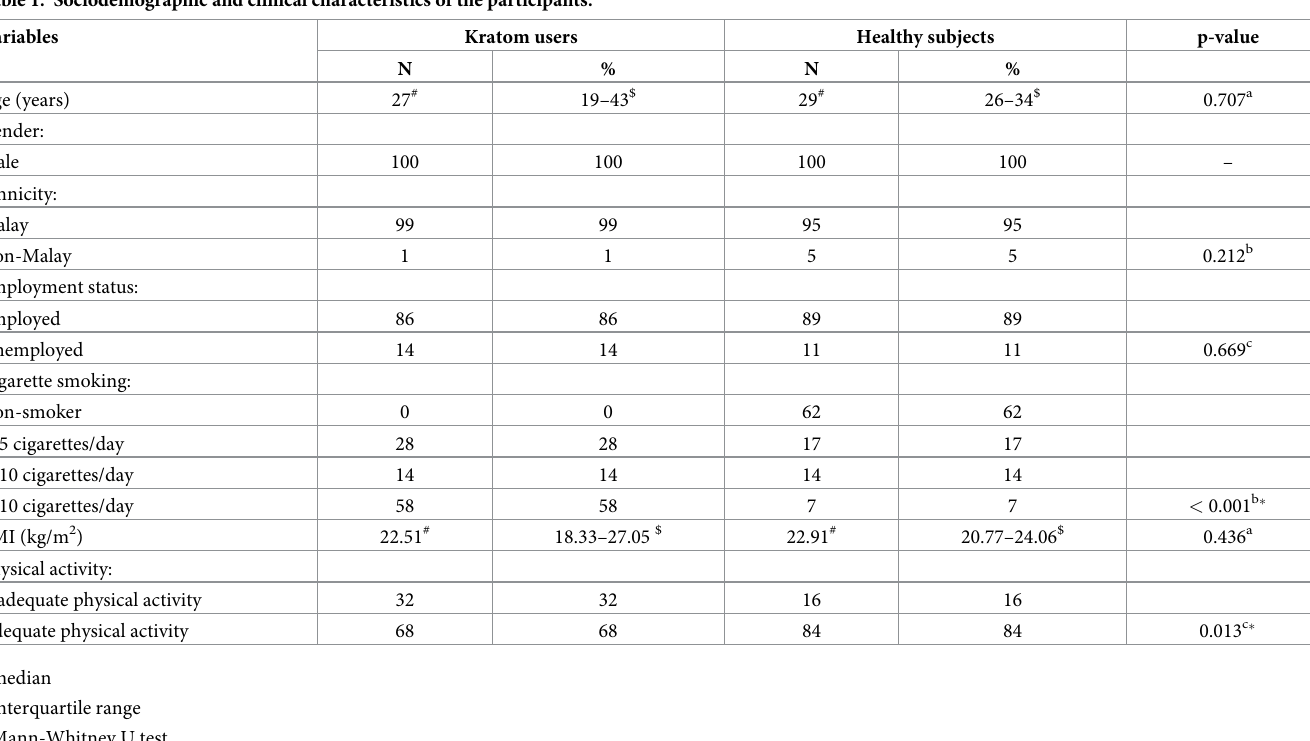
Table 1. Sociodemographic and clinical characteristics of the